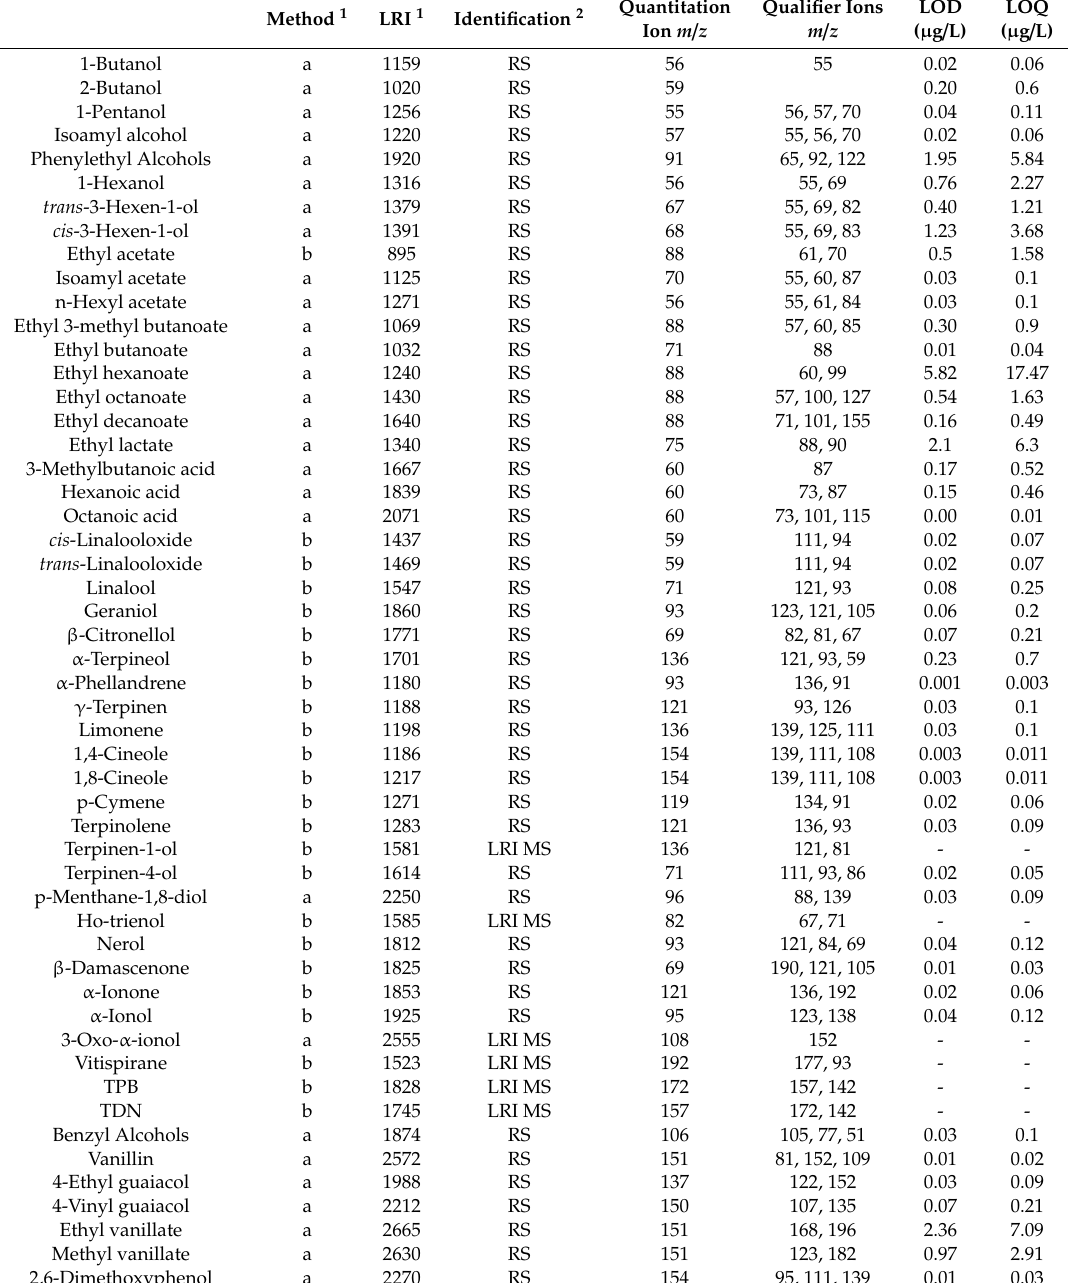
Table 6. Retention indices, quantification ions of studied